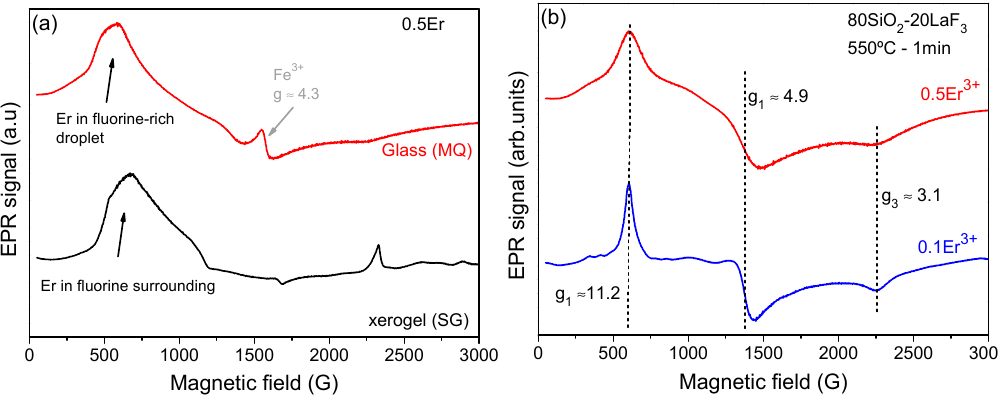
Figure 8. ( a ) Electron Paramagnetic Resonance (EPR) signals for the 80SiO 2 -20LaF 3 -0.5Er 3+ (TEOS-MTES). xerogel and of an MQ glass doped with 0.5Er 3+ . ( b ) EPR signals of 80SiO 2 -20LaF 3 (TEOS-MTES) GCs doped with 0.1 and 0.5Er 3+ (mol%) treated at 550 ° C for 1 min.